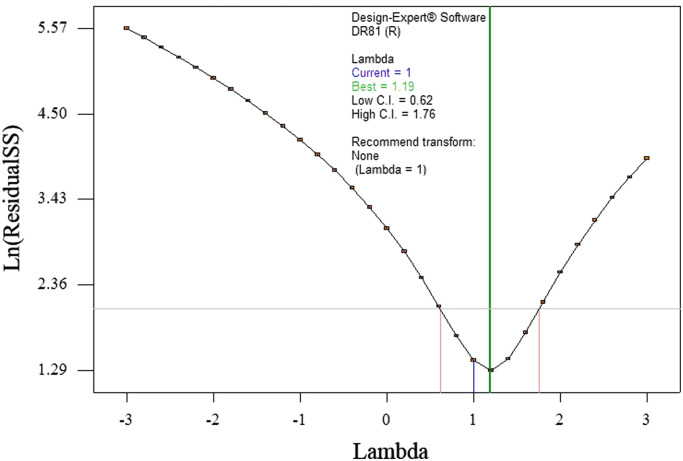
Box-Cox plot of RSM model transformation.